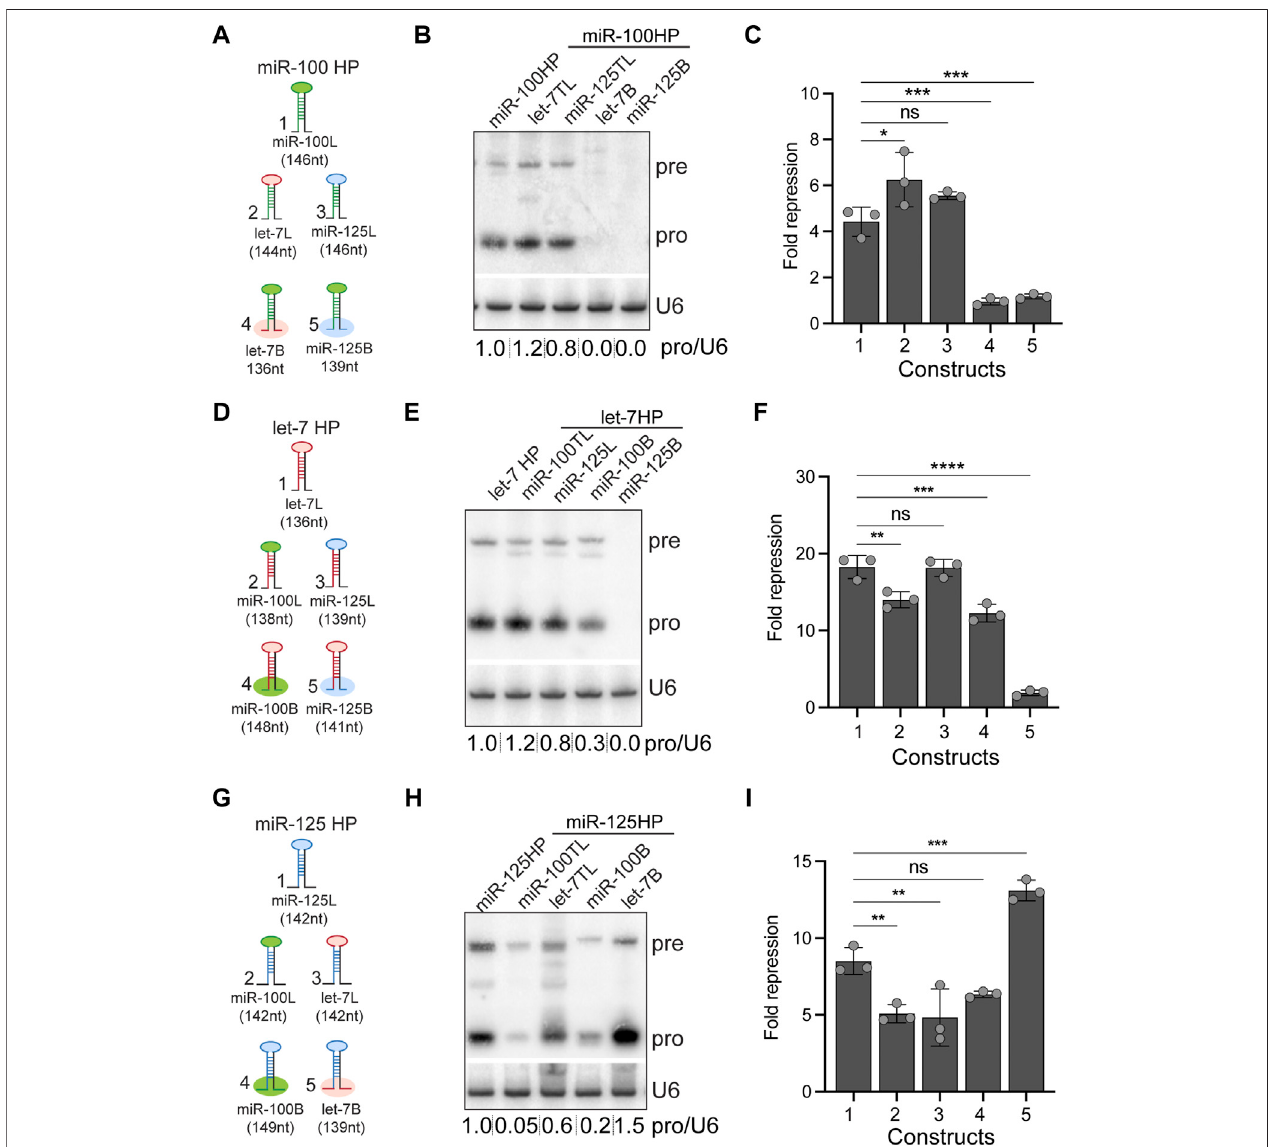
FIGURE 3 | Expression and activity of let-7-Complex pri-miRNA monocistronic chimeras. (A) Schematic representation of UAS constructs used for experiments indicatedinpanels (B,C) . (B) SmallRNAnorthernblotoftotalRNAextractedfromKc167cellstransfectedwithTubulinGal4andoneofthefollowingconstructs:UASpri- miR-100, UAS pri-miR-100H let-7 terminal loop (TL) chimera, UAS pri-mir-100H miR-125TL chimera, UAS pri-miR-100H let-7B, or UAS pri-miR-100HmiR-125B. The Northernblotwasprobedfor miR-100 and U6snRNA wasusedasnormalizationcontrol. (C) Luciferasesensorassayanalysistodeterminethefunctionalactivityof the UAS pri-miR-100 chimeric constructs. Fold repression of miR-100 sensor in Kc167 cells transfected with UAS constructs represented in panel (A) . Data are represented as mean ± SD, n = 3. p -value calculated by ordinary one-way ANOVA for miR-100 sensor is 1.51E-06. Adjusted p -values after applying Bonferroni ’ s correction are represented in the fi gure panel and we used an α level of 0.05 to assess statistical signi fi cance. (D) Schematic representation of UAS constructs used for experiments indicated in panels (E,F) . (E) RNA northern blot of total RNA extracted from Kc167 cells transfected with Tubulin Gal4 and one of the following constructs: UAS pri-let-7, UAS pri-let-7HmiR-100TL chimera, UAS pri-let-7HmiR-125TL, UAS pri-let-7HmiR-100B, or UAS pri-let-7HmiR-125B. The Northern blot was probed for let-7 and U6snRNA wasused asnormalization control. (F) Luciferase sensor assay analysisto determine thefunctionalactivity ofthe UAS pri-let-7 chimeric constructs. Fold repression of let-7 sensor in Kc167 cells transfected with Tubulin Gal4 and UAS constructs represented in panel (G) . Data are represented as mean ± SD, n = 3. p -value calculated byordinary one-way ANOVA for let-7 sensor is3.00E-08.Adjusted p -values after applyingBonferroni ’ s correction are represented in the fi gure panel and weusedan α levelof0.05toassess statisticalsigni fi cance. (G) Schematicrepresentation ofUASconstructsused forexperimentsindicatedinpanels (H,I) . (H) RNA northernblotoftotalRNAextracted from Kc167cellstransfected withTubulinGal4and oneofthefollowingconstructs: UASpri-miR-125, UAS pri-miR-125miR-100TL chimera,UASpri-miR-125let-7TL,UASpri-miR-125HmiR-100B,orUASpri-miR-125Hlet-7B.TheNorthernblotwasprobedfor miR-125 and U6snRNA wasusedasa controlfornormalization. (I) LuciferasesensorassayanalysistodeterminethefunctionalactivityoftheUASpri-miR-125chimericconstructs.Foldrepressionof miR-125 sensor in Kc167 cells transfected with Tubulin Gal4 and UAS constructs represented in panel (G) . Data are represented as mean ± SD, n = 3. p -value calculated by ordinaryone-wayANOVAfor miR-125 sensoris8.03E-06. Adjusted p -valuesafterapplyingBonferroni ’ scorrectionarerepresentedinthe fi gurepanelandweusedan α level of 0.05 to assess statistical signi fi cance.